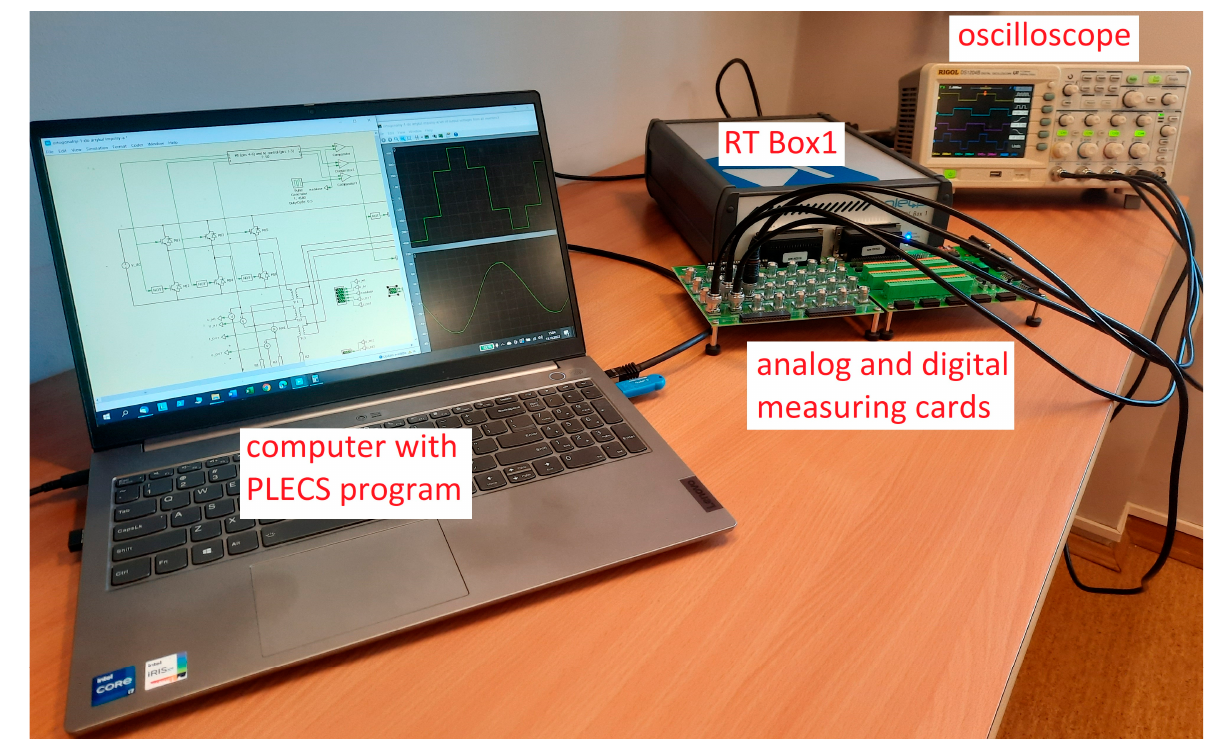
Figure 10. The workstation for the simulation research.